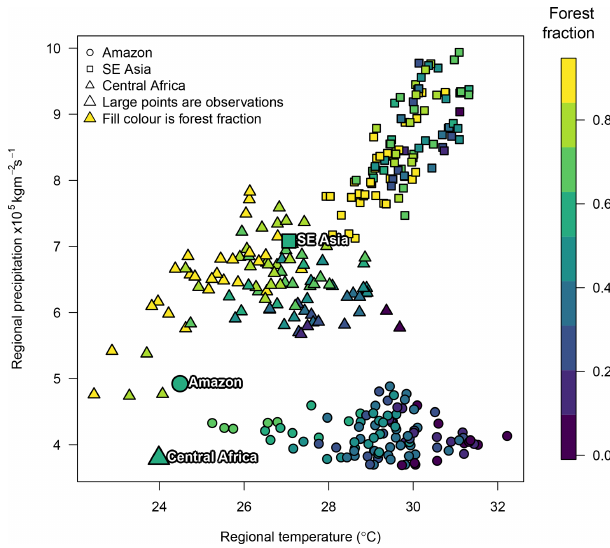
Figure 3. Regional temperature, precipitation and broadleaf for- est fraction in the ensemble of FAMOUS compared with observa- tions. Smaller symbols represent broadleaf forest fraction in the FA- MOUS ensemble against regional mean temperature and precipita- tion. Ensemble member forest fraction in the Amazon is represented by the colour of the circles, central Africa by triangles and SE Asia by squares. Larger symbols represent observed climate and forest fraction.